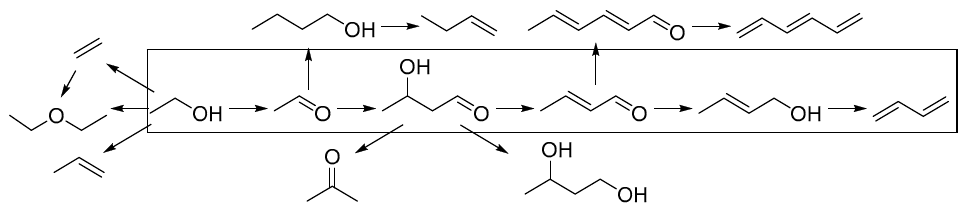
Figure 5. Reaction network of the main byproducts [8,16]. The Kagan mechanism intermediates and product are inboxed.